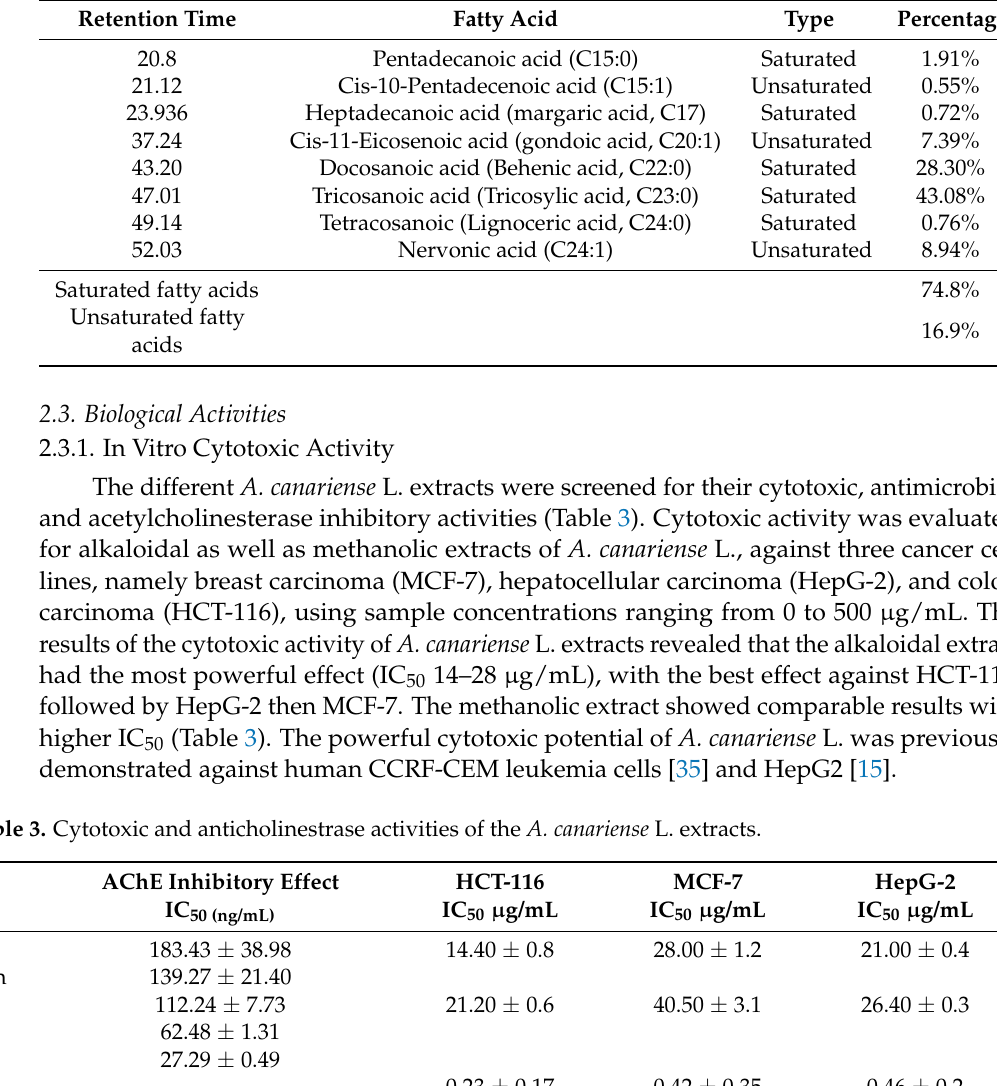
Table 2. Tentatively identified fatty acids in aerial parts of the petroleum ether extract A. canariense L.